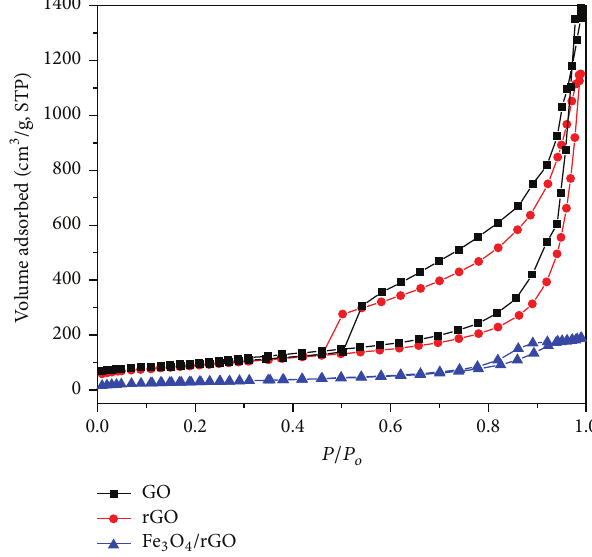
Figure 6: Nitrogen adsorption/desorption isotherms of GO, rGO, and Fe 3 O 4